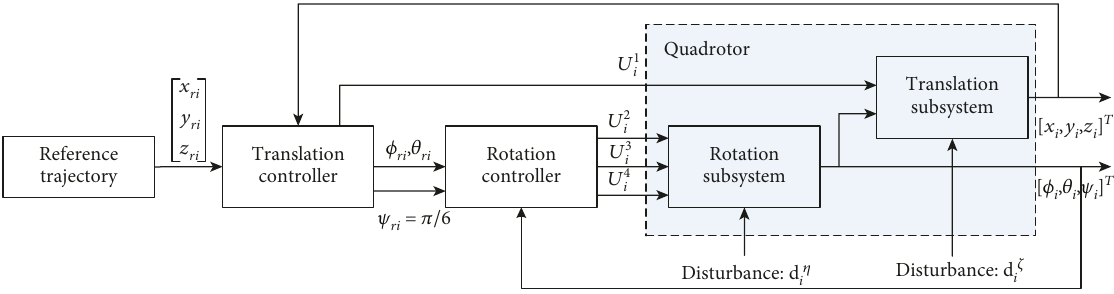
Figure 1: The distributed control scheme for each quadrotor.